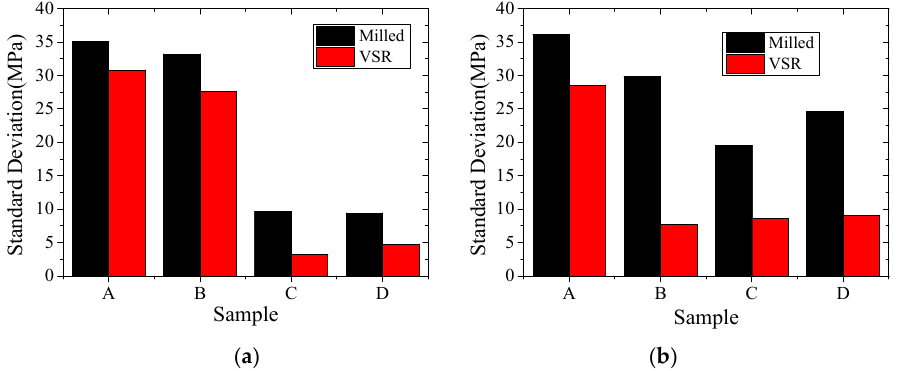
Figure 16. Standard deviation of surface stress before and after VSR. ( a ) X stress; ( b ) Y stress.